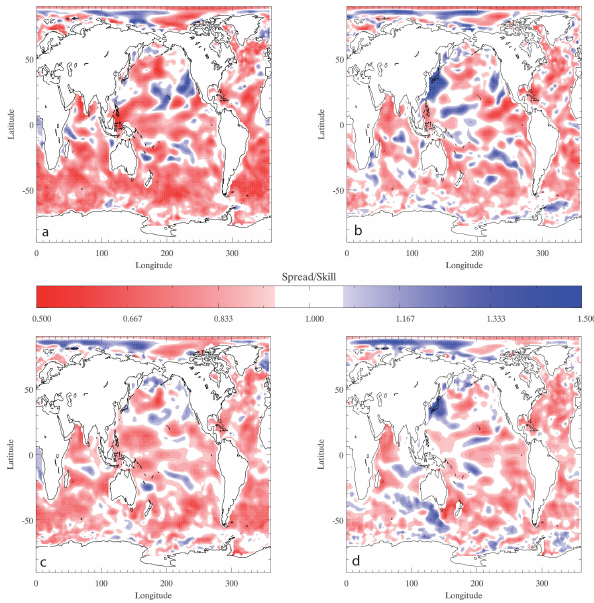
Fig. 5. Spread–error ratios for temperature averaged over 0–700m depth, and for lead times of 2–4 months (a, b) , and one year (c, d) for the lagged initialized ensemble (a, c) , and the bred initialized ensemble (b, d) .